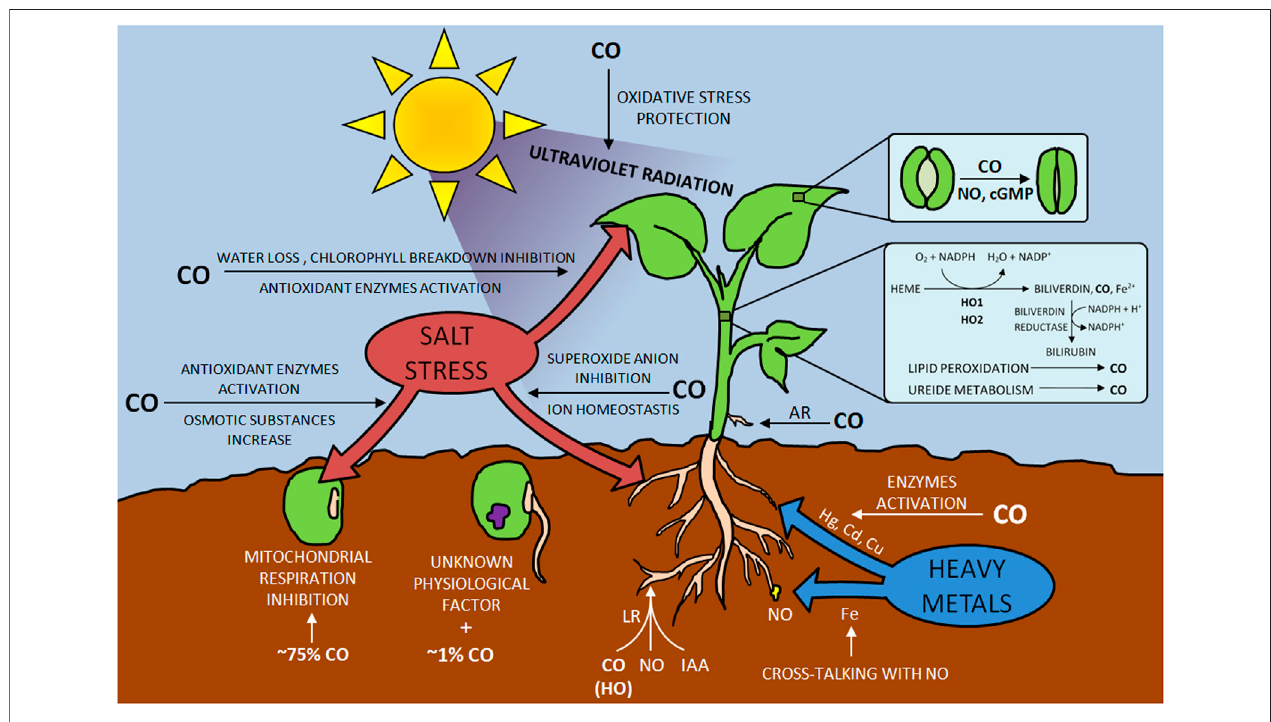
FIGURE 3 | Impact of CO on plants